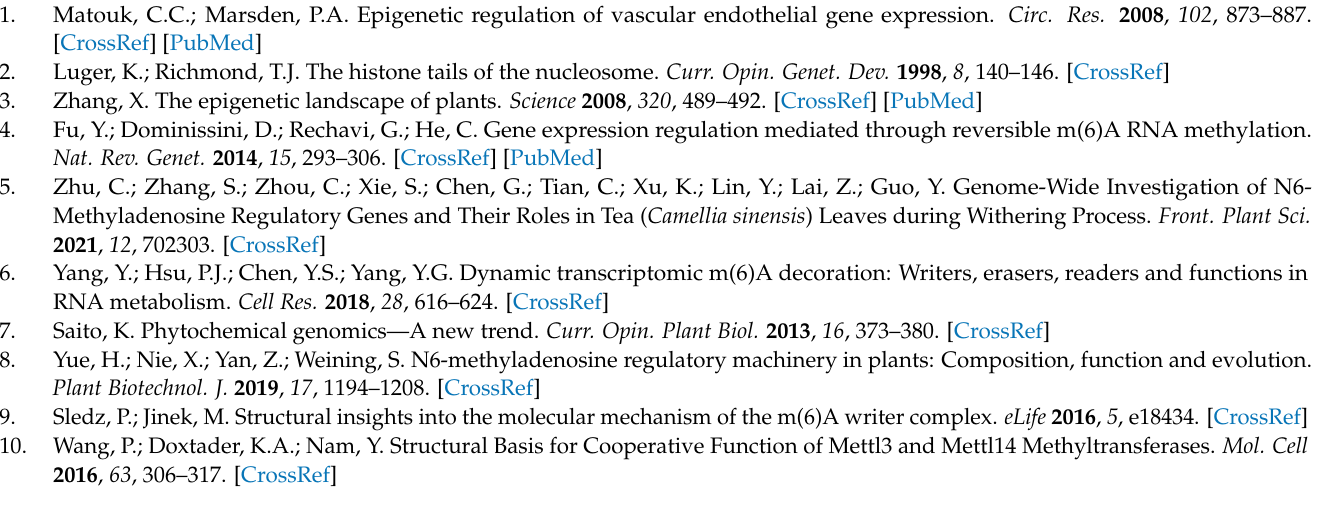
Table S1: The detailed information of cis -elements, Table S2: The FPKM values of 26 m6A regulatory genes in C. grandis